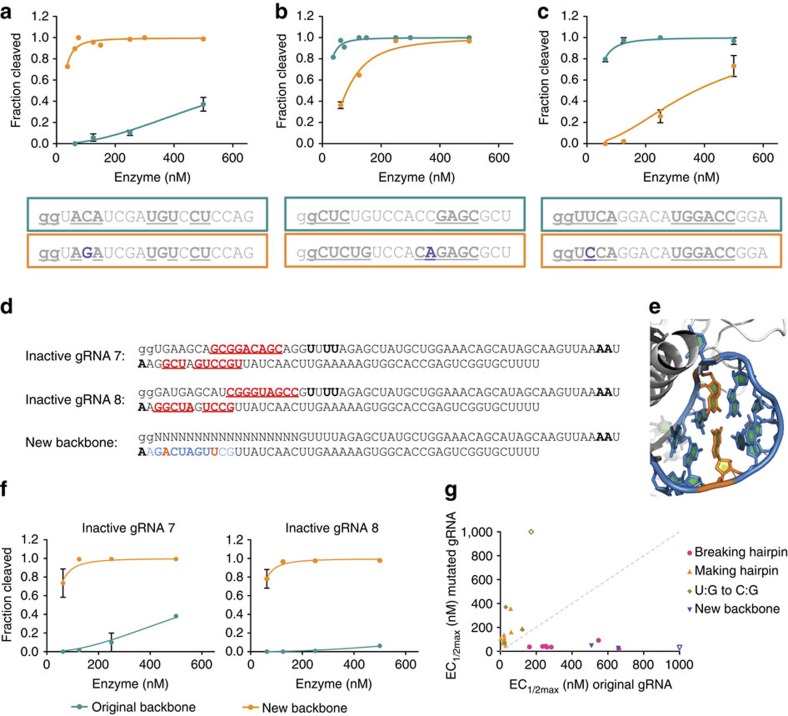
Internal hairpins in gRNAs reduce cleavage activity.(a) Breaking a gRNA interaction in a gRNA with low activity increases cleavage activity. The interacting region is indicated by bold and underlined text, whereas the single base-pair substitution is shown in purple. (b) Extending the potential hairpin of an active gRNA reduces cleavage activity. (c) Substitution of a G:U base pair with the canonical G:C base pair reduces cleavage activity. (d) Potential hairpins between the gRNA sequence and the constant region of the gRNA for two inactive gRNAs (Supplementary Table 2) and a mutated backbone that was designed to eliminate the interactions. (e) Substituted nucleotides in the new backbone shown in d, using pdb code 4OO8 (ref. 19) for visualization. (f) Cleavage activity of the two inactive gRNAs with the original and newly designed constant gRNA backbone. (g) Summary of the EC1/2max differences for gRNAs with small numbers of substitutions that alter cleavage activity. The grey dashed y=x line represents the expected location of the points if the substitution did not have an effect on cleavage. Open shapes represent gRNAs with an EC1/2max too high (>1,000 nM) to be accurately measured under tested conditions. At least two independent assays were completed for each in vitro cleavage experiment and error bars shown in all panels are s.e.m.